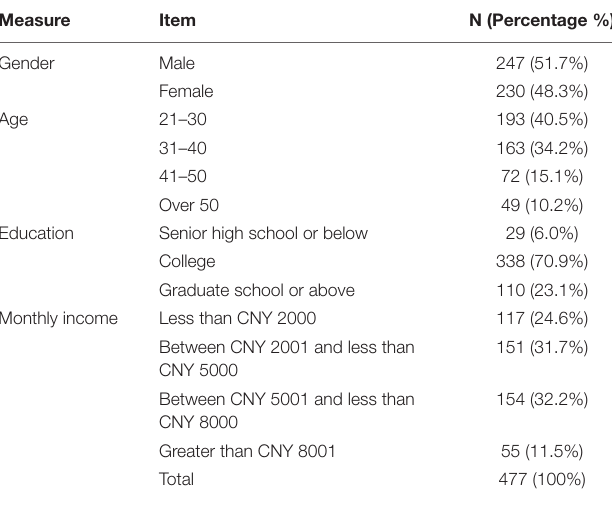
TABLE 1 | Analysis of sample demographic variables ( n =